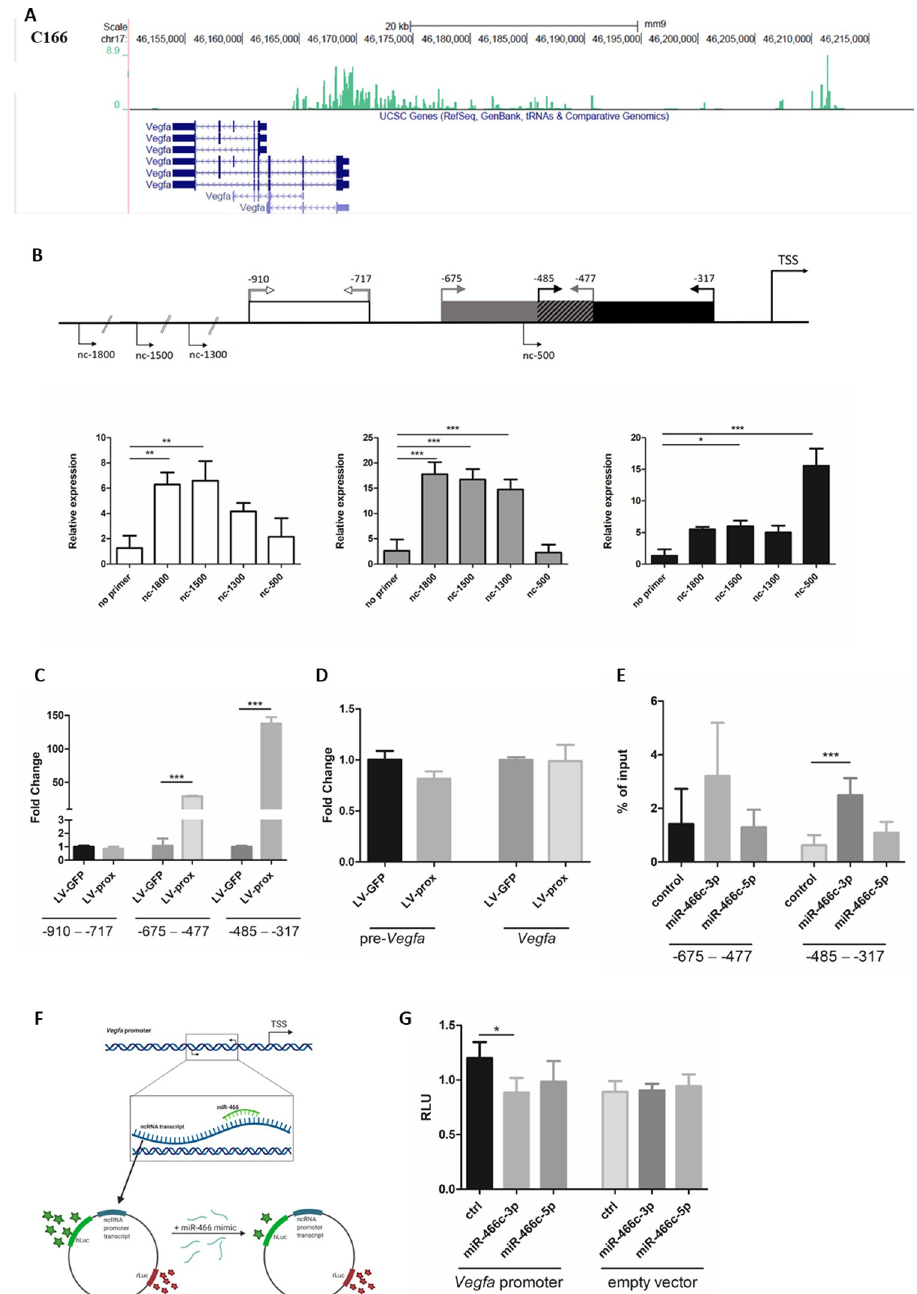
Fig 4. Murine Vegfa promoter is associated with antisense non-coding transcript, which is the target for miR- 466c. A. GRO-seq shows antisense lncRNA at Vegfa promoter in C166 cells. B. Antisense ncRNA is detected from Vegfa promoter using strand-specific qPCR. ncRNA is found from the regions that were predicted for miR-466c targeting. n = 3, ANOVA with Bonferroni correction was used for determining the statistical significance, data is represented as mean ± SD. C. qPCR of ncRNA shows increased levels of antisense ncRNA after transduction with lentiviral vector encoding the proximal promoter region (LV-prox). n = 3, t-test was used for determining the statistical significance, data is represented as mean ± SD. D. Overexpression of Vegfa promoter-associated ncRNA with lentiviral vector (LV-prox) does not affect expression levels of Vegfa . n = 3, data is represented as mean ± SD. E. Biotinylated miR-466c mimic was used to pulldown RNA transcripts binding to miR-466c. Vegfa promoter associated ncRNA was detected from the pulldown samples by RT-qPCR. n = 5, ANOVA with Bonferroni correction was used for determining the statistical significance, data is represented as mean ± SD. F. Schematic illustration of